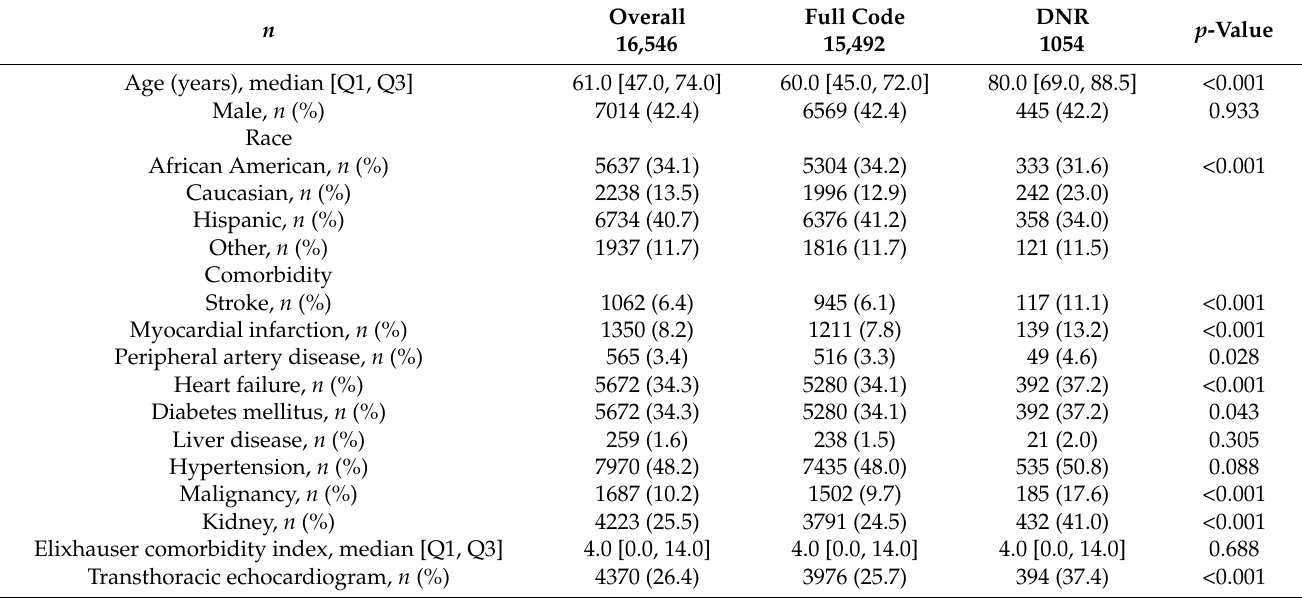
Table 1. Patient